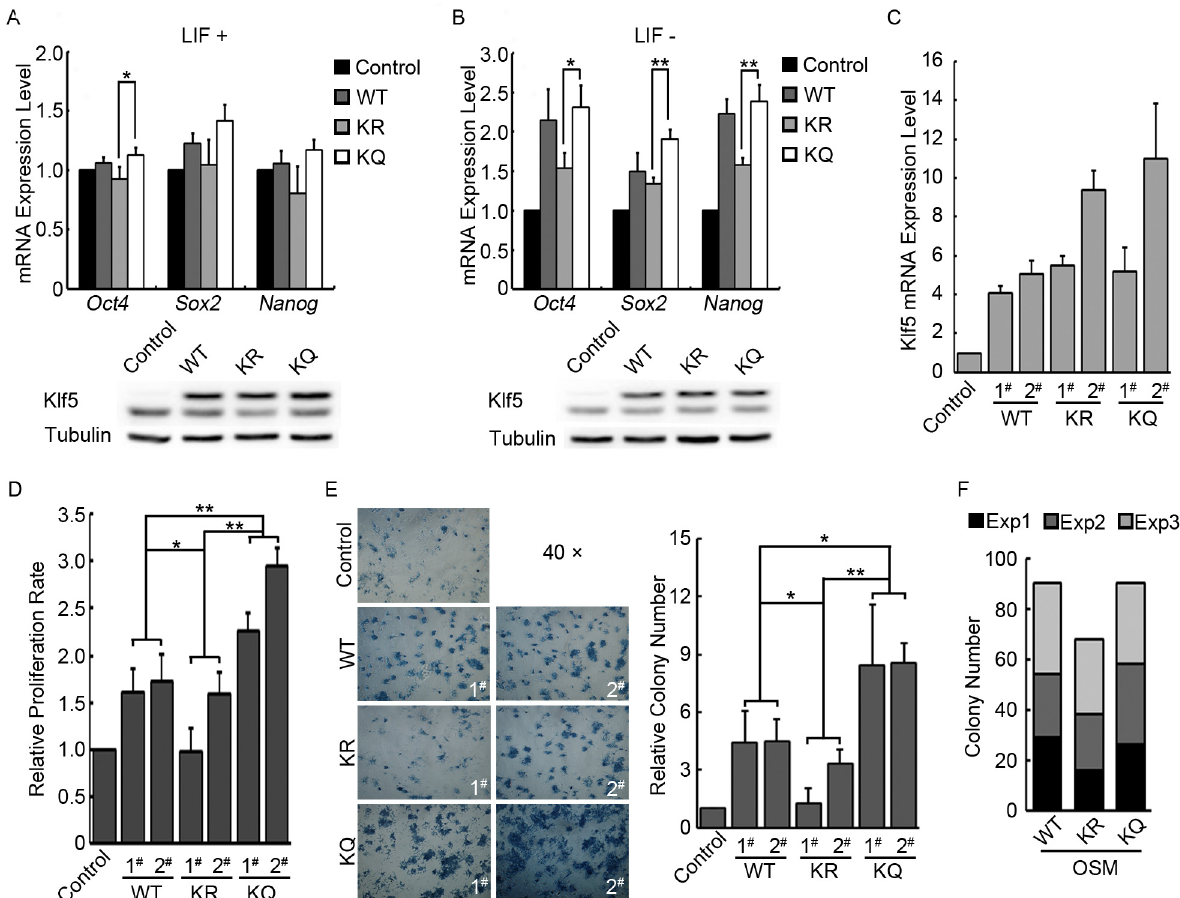
Fig 2. Functions of Ac-Klf5 in self-renewal and pluripotency regulation. (A) The effect of WT, KR, and KQ Klf5 overexpression on the expression of pluripotency genes in mouse ESCs. Empty pCAGIPuro, Flag-tagged WT, KR and KQ Klf5 overexpression plasmids were transfected into V6.5 ESCs with Lipofectamine 3000. Two days after transfection, cells were harvested and subjected to RNA purification or Western blot. The top panel shows RNA quantification results (averages and standard deviations from three independent experiments were plotted), and the bottom panel shows Western blots to demonstrate the similar expression levels of Flag-tagged WT, KR and KQ Klf5. (B) The effect of WT, KR, and KQ Klf5 overexpression on the expression of pluripotency genes during mouse ESC differentiation. Experiments were carried out as described in (A), except for that LIF was withdrawn from the medium upon transfection. Averages and standard deviations from three independent experiments were plotted. (C) Relative expression level of total Klf5 mRNA in control, WT, KR, and KQ Klf5 overexpression ESC lines. Averages and standard deviations from three independent experiments were plotted. (D) Proliferation rates of control, WT, KQ, and KR Klf5 overexpression ESCs. 1.5×10 5 Cells were seeded in one well of a 6-well plate, and 48 hours later, total cell number was counted to measure the proliferation rate. Averages and standard deviations from three independent experiments were plotted. P values were calculated by reusable two-factor analysis of variance. (E) Colony forming assays for control, WT, KR, and KQ Klf5 overexpression ESCs growing without LIF and feeder cells. The left panel shows the image of AP stained colonies of each ESC line, and the quantification result of colony number is plotted in the right panel. Averages and standard deviations from three independent experiments were plotted. P values were calculated by reusable two-factor analysis of variance. (F) Reprogramming ability of WT, KR, and KQ Klf5 in combination with Oct4, Sox2 and c-Myc. MEFs were reprogrammed by WT, KQ, or KR Klf5, together with Oct4, Sox2, and c-Myc. Accumulated iPS colony numbers of three independent experiments (labeled with three different colors) are shown in the